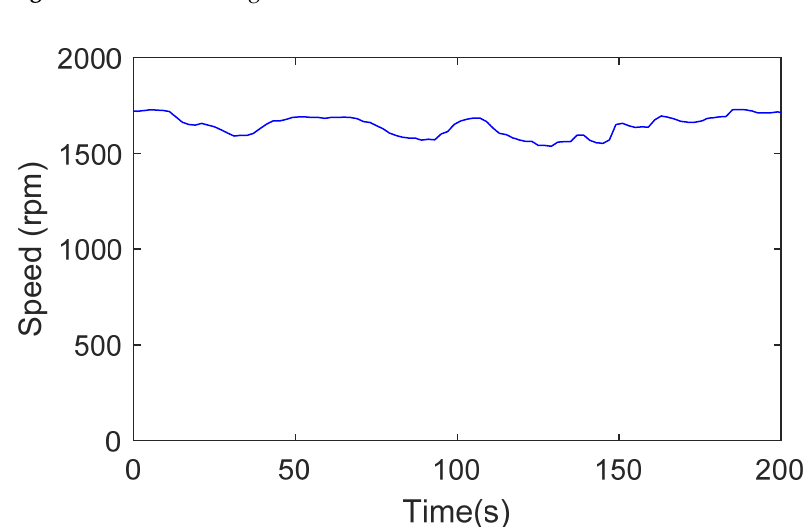
Figure 10. DC-bus voltage.